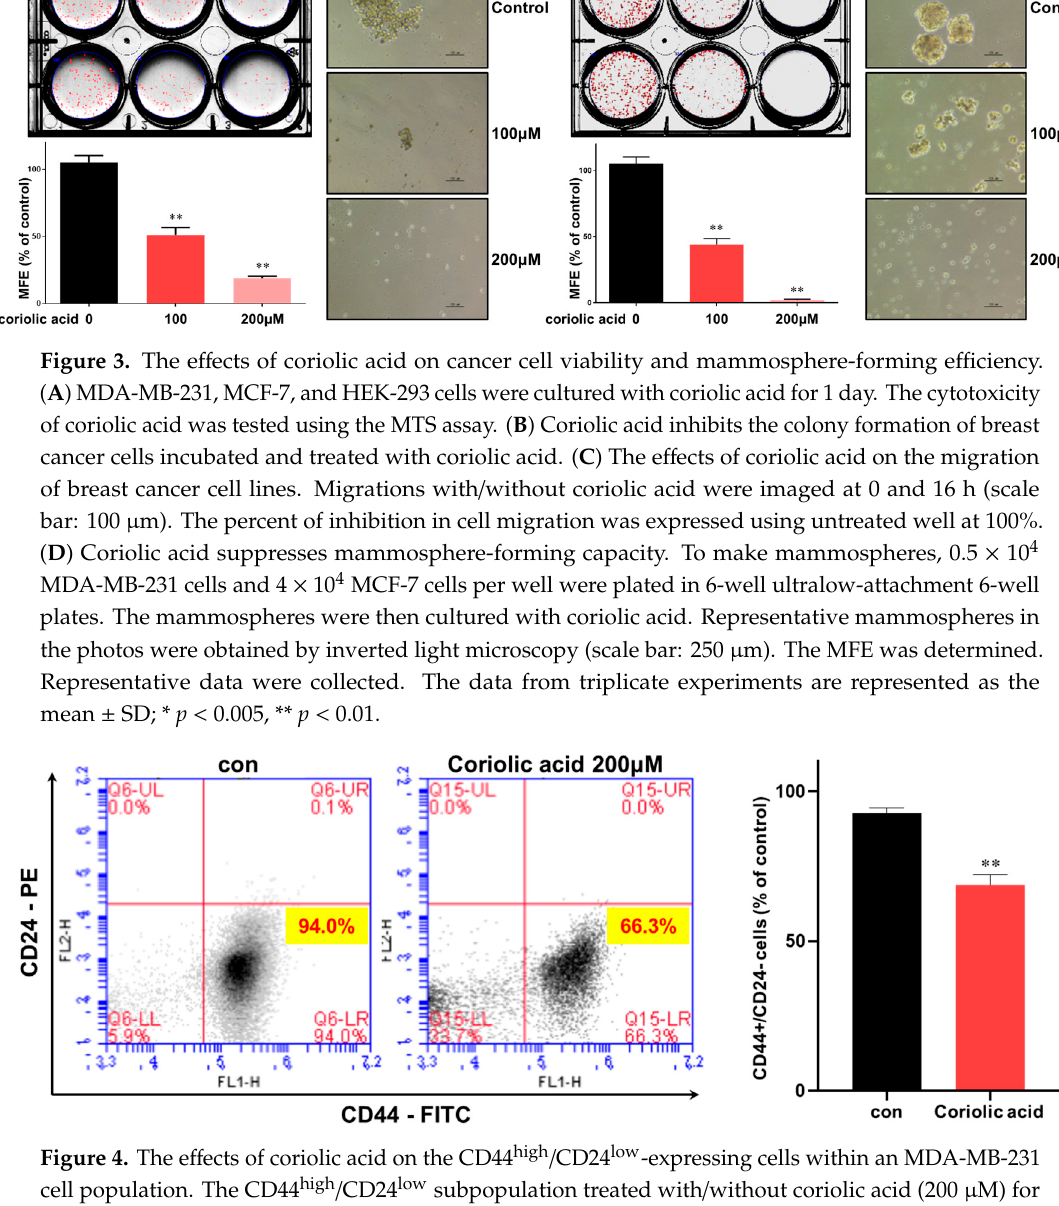
Figure 4. The effects of coriolic acid on the CD44 high /CD24 low -expressing cells within an MDA-MB-231 cell population. The CD44 high /CD24 low subpopulation treated with/without coriolic acid (200 µM) for 1 day was tested by flow cytometry. For this analysis, 2 × 10 4 cells were utilized. The red cross was based on the binding of an antibody without coriolic acid. The data are represented as the mean ± SD; ** p < 0.01.